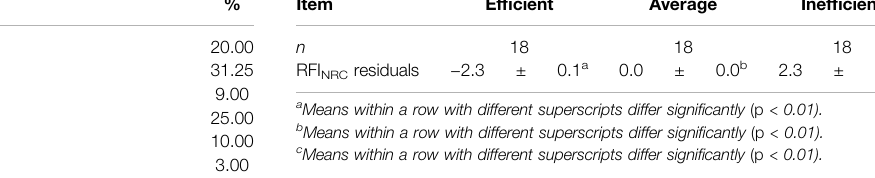
TABLE 2 | Simple means (±STD err) for RFI NRC residuals by ef fi ciency groups. Item